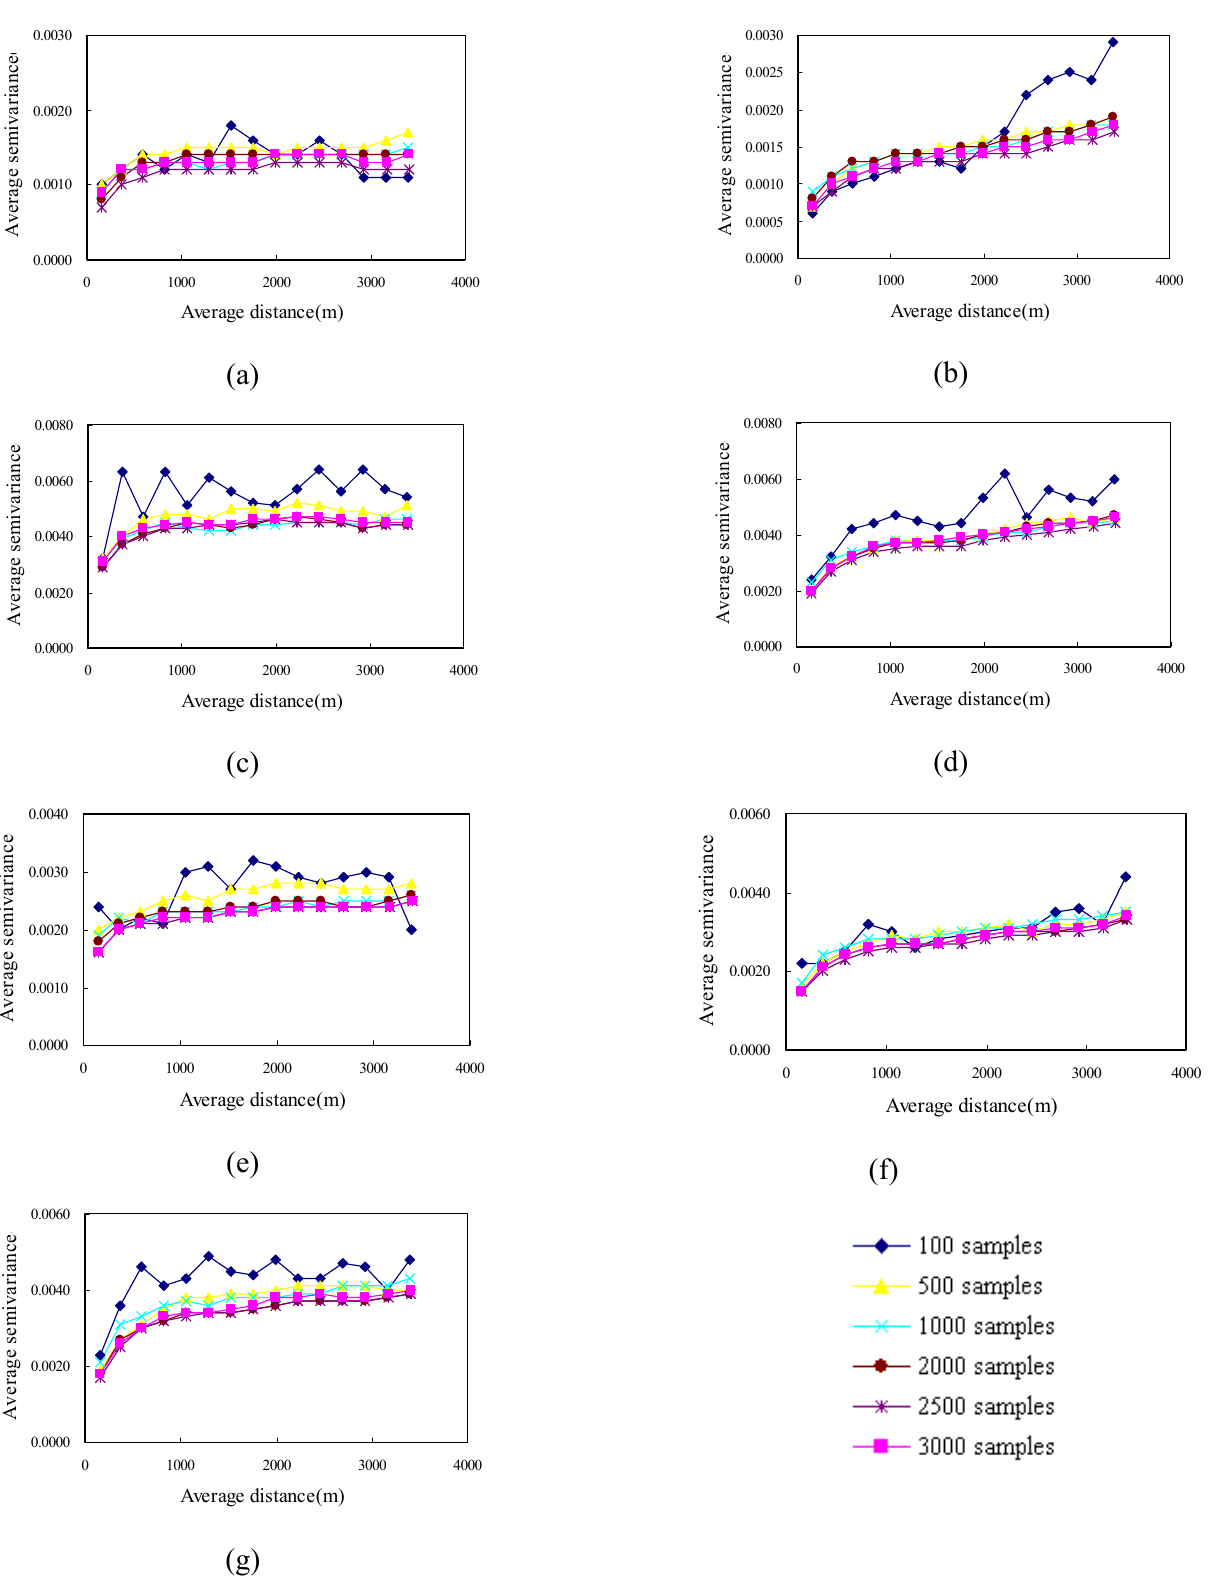
Figure 6 Experimental variograms of NDVI samples for area B on (a) 1996/11/08, (b) 1999/03/06, (c) 1999/10/31, (d) 2000/11/27, (e) 2001/11/20, (f) 2003/12/17, and (g)